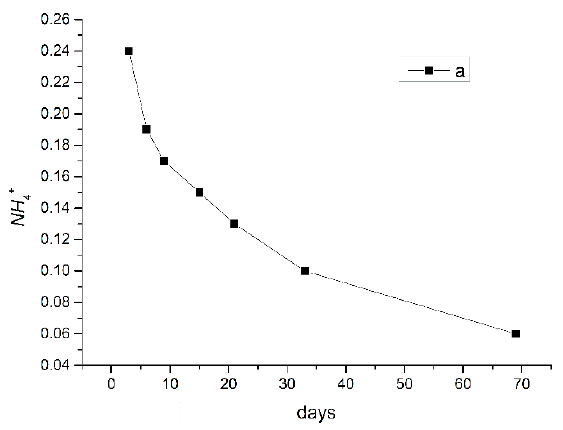
Figure 6. Ammonium ion concentration curve of liquids with oil shale heated to 300 °C.